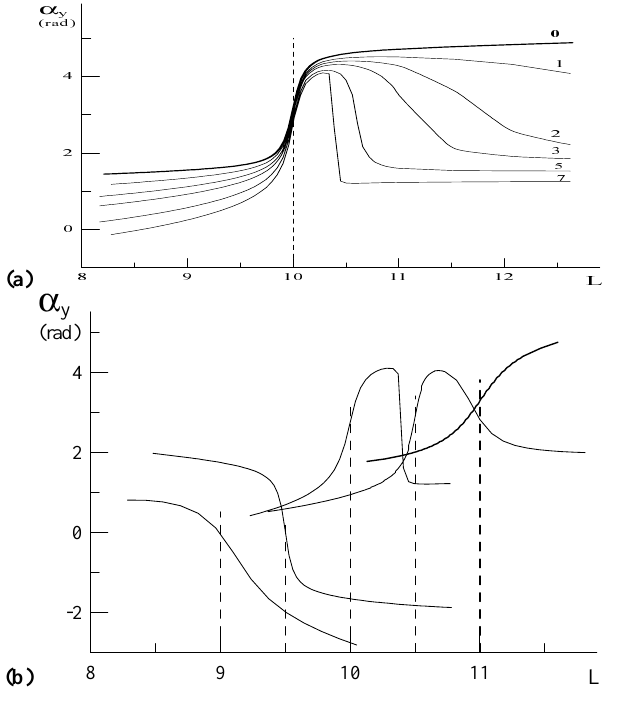
Fig. 6. The distribution of the resonant Alfv´en oscillation am- plitude | B y | across magnetic shells. Panel (a) shows the distribu- tion of | B y (x 1 ) | on the magnetic shell L = 10 for the harmonics N = 1 , m = 1 , 5, both in the moving plasma model (solid lines) and in the stationary plasma case (dashed lines). Panel (b) presents the distribution of | B y (x 1 ) | inside the transition layer for the harmonic N = 1 , m = 7, on different resonant shells (left semiaxis), as well as of the plasma angular velocity (cid:127)(x 1 ) (right